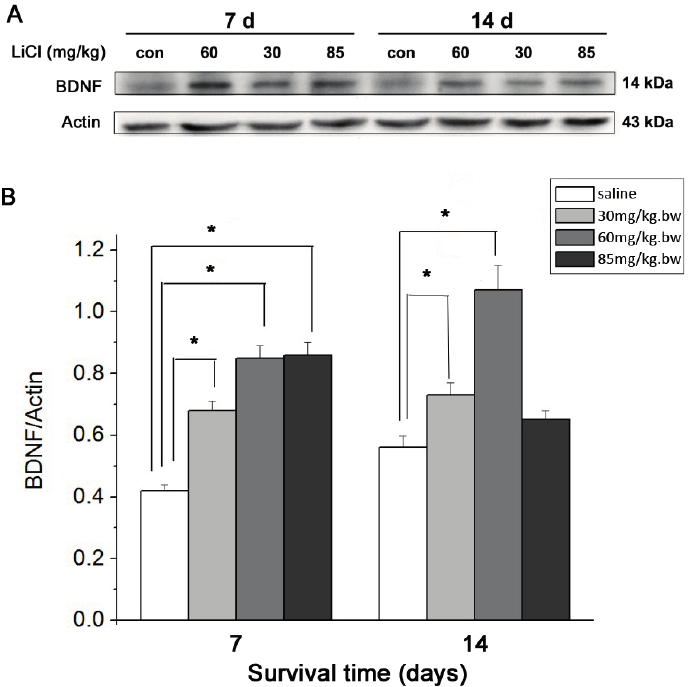
Figure 4. Western Blot assay and densitometric analysis showing the changes of the BDNF protein level at 7 and 14 day time points. ( A ) Representative picture of the immunoblot of BDNF in different LiCl groups and Control groups ( n = 3 for each dosage and time point) at 7 and 14 day time points; ( B ) Quantitative analysis of Western Blot showing different protein levels of BDNF in LiCl and Control groups ( n = 3 for each dosage and time point) at 7 and 14 day points. The asterisks indicate higher protein levels of BDNF ( * p < 0.01) in LiCl groups when compared to those in Control groups at 7 and 14 day points. Error bars =